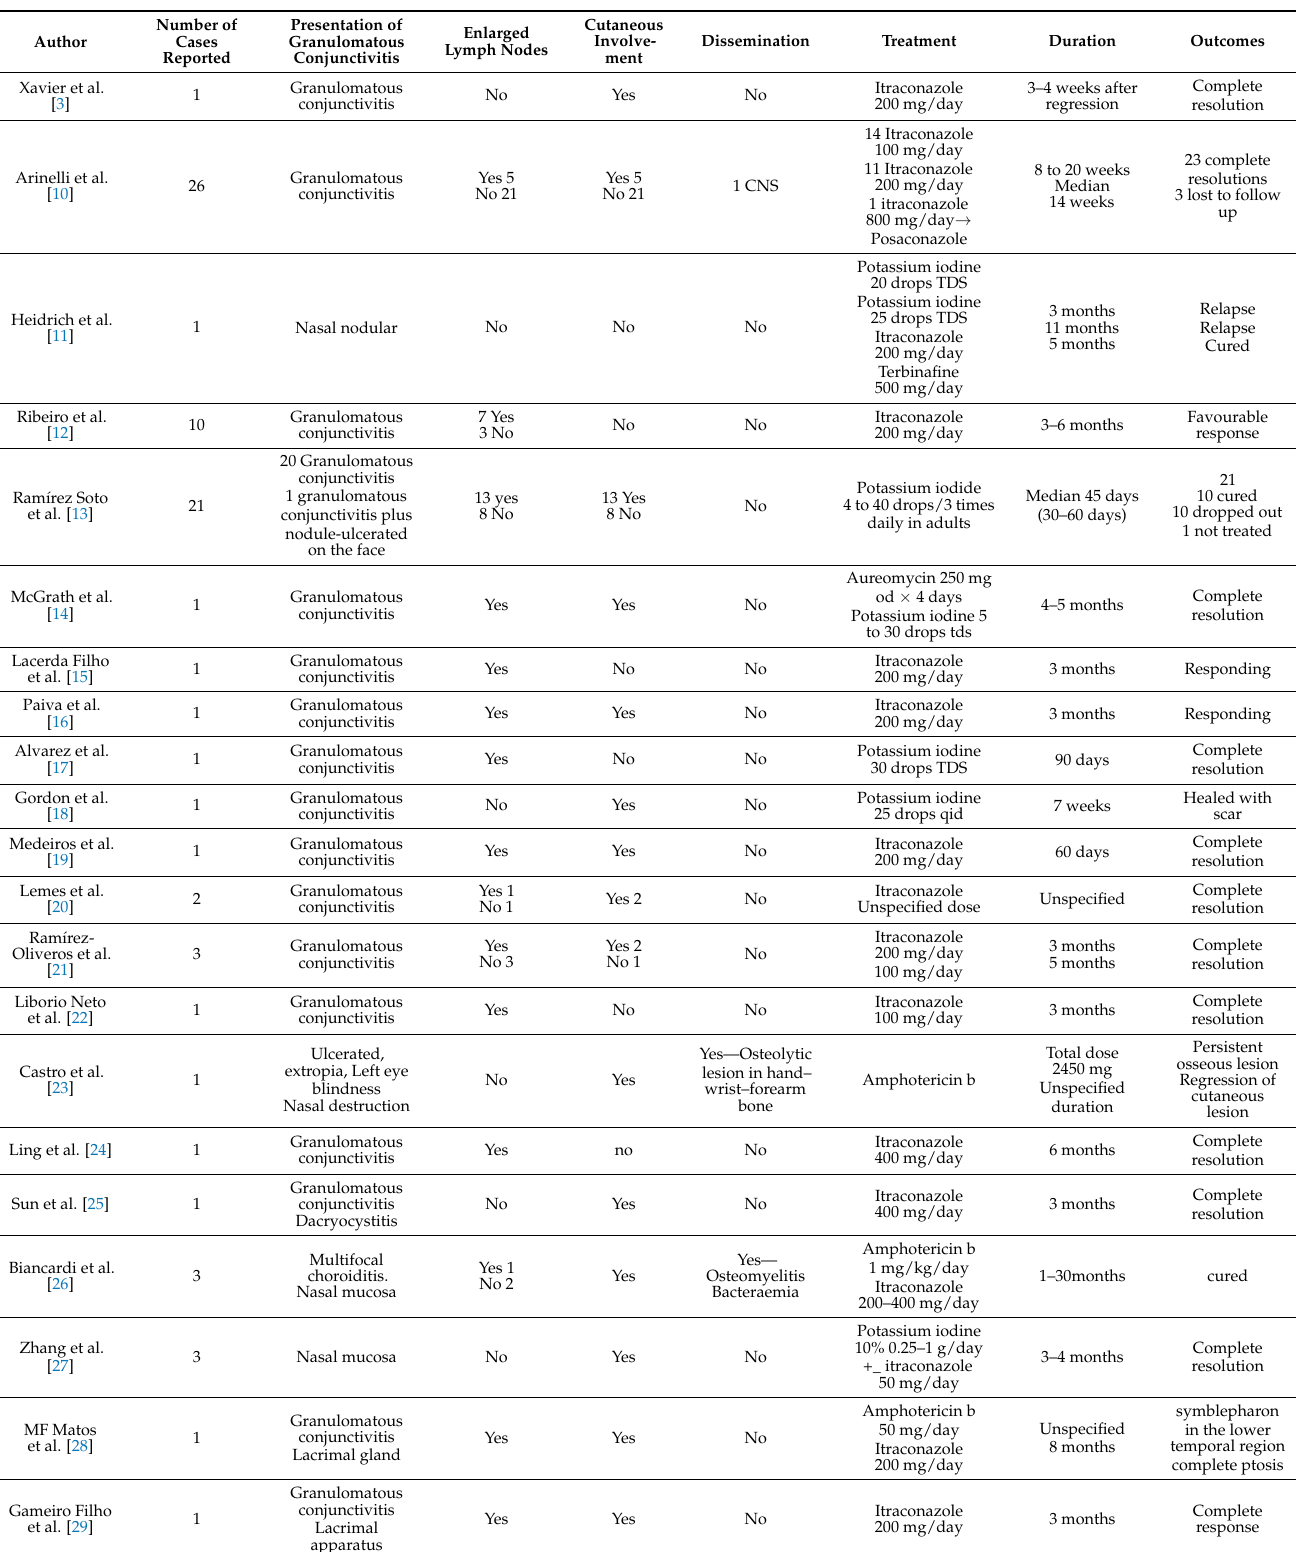
Table 2. Clinical manifestations of mucosal sporotrichosis and courses of treatment with